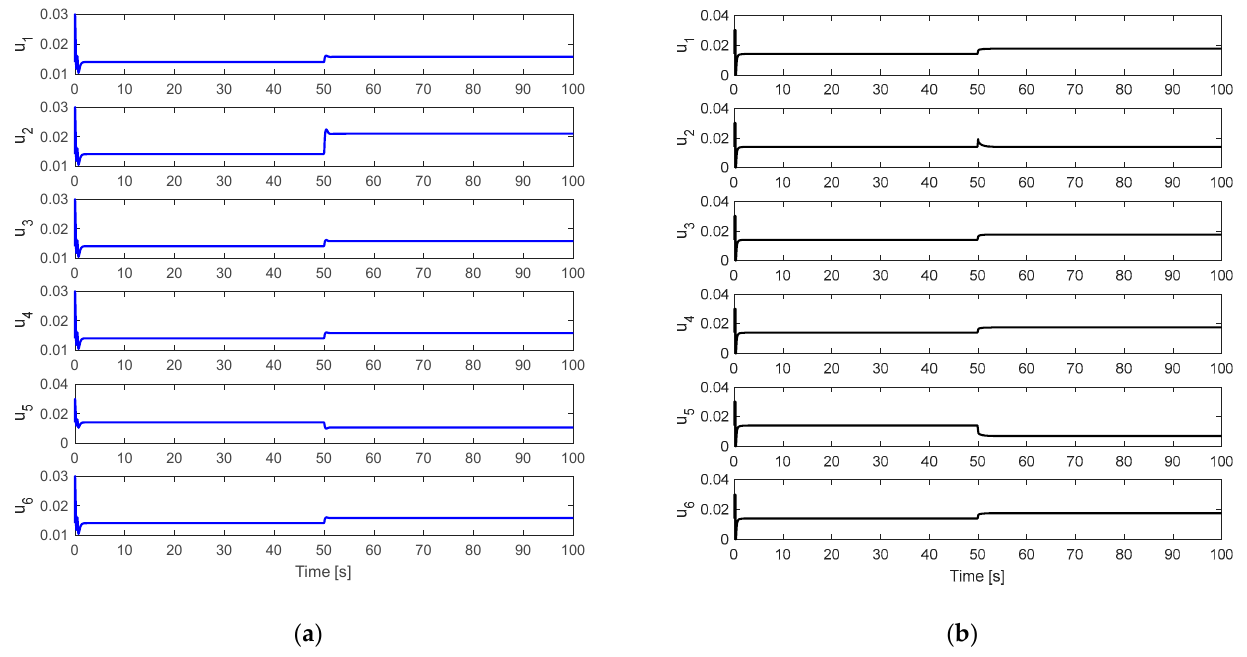
Figure 4. Response of motor’s command with 50% LoCE in actuator #2: ( a ) ASMC; ( b ) Proposed FTC.